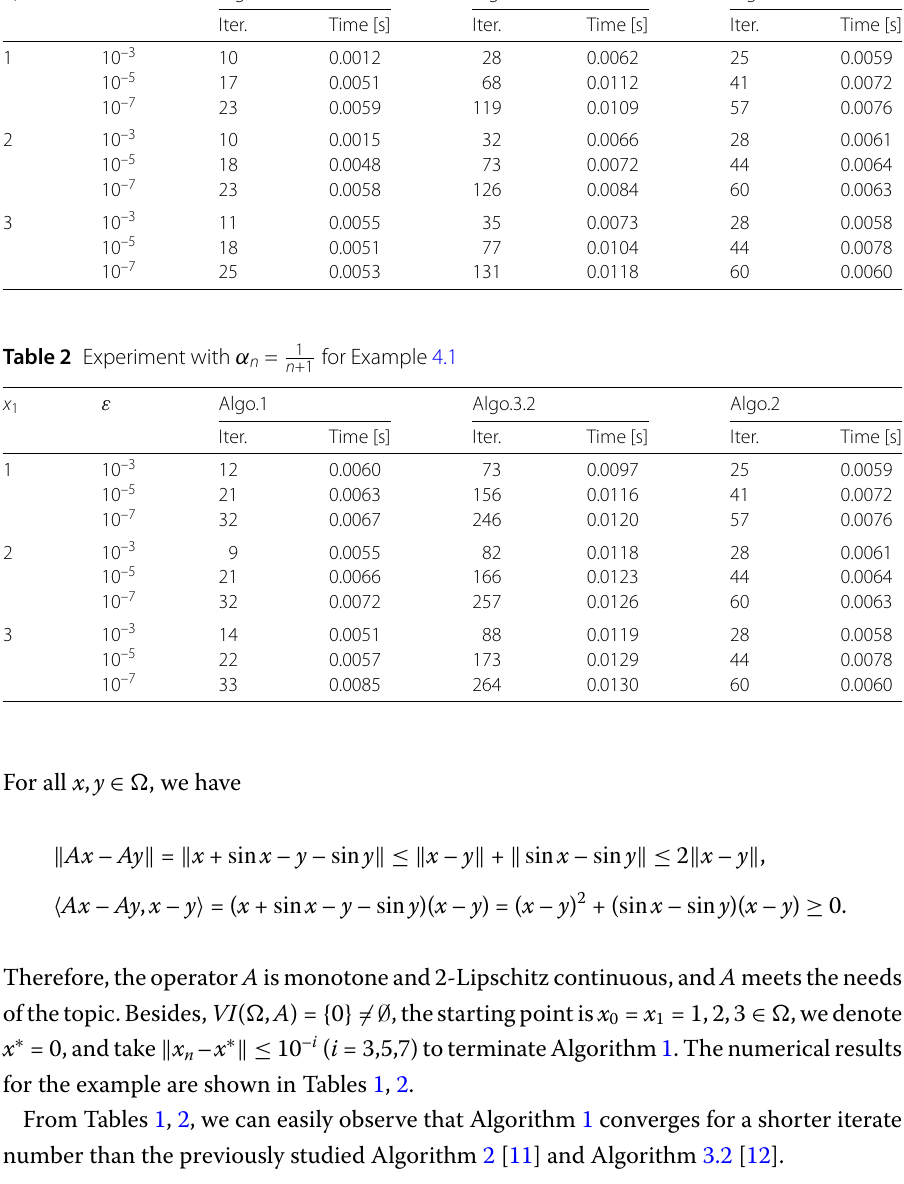
Table 1 Experiment with α n =